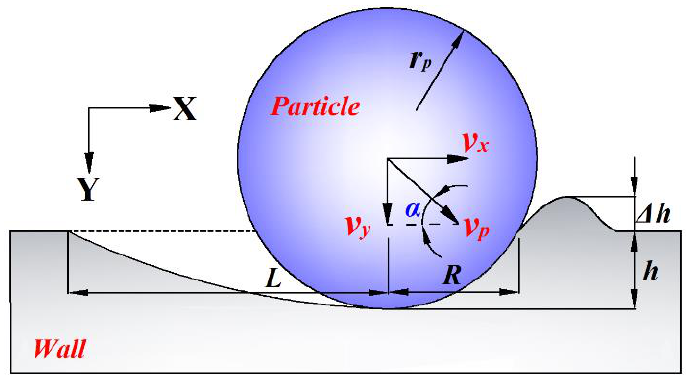
Figure 2. Schematic diagram of wall extrusion deformation caused by a particle impingement.